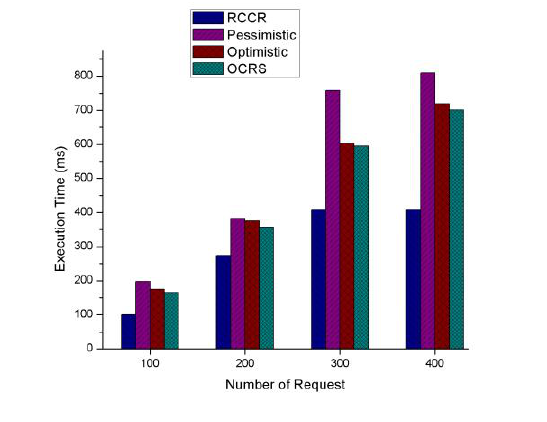
Figure 5. Average execution